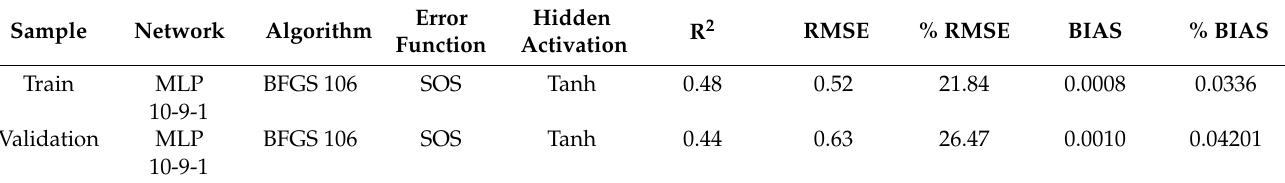
Table 8. The results of the MLP model for the training and validation step.